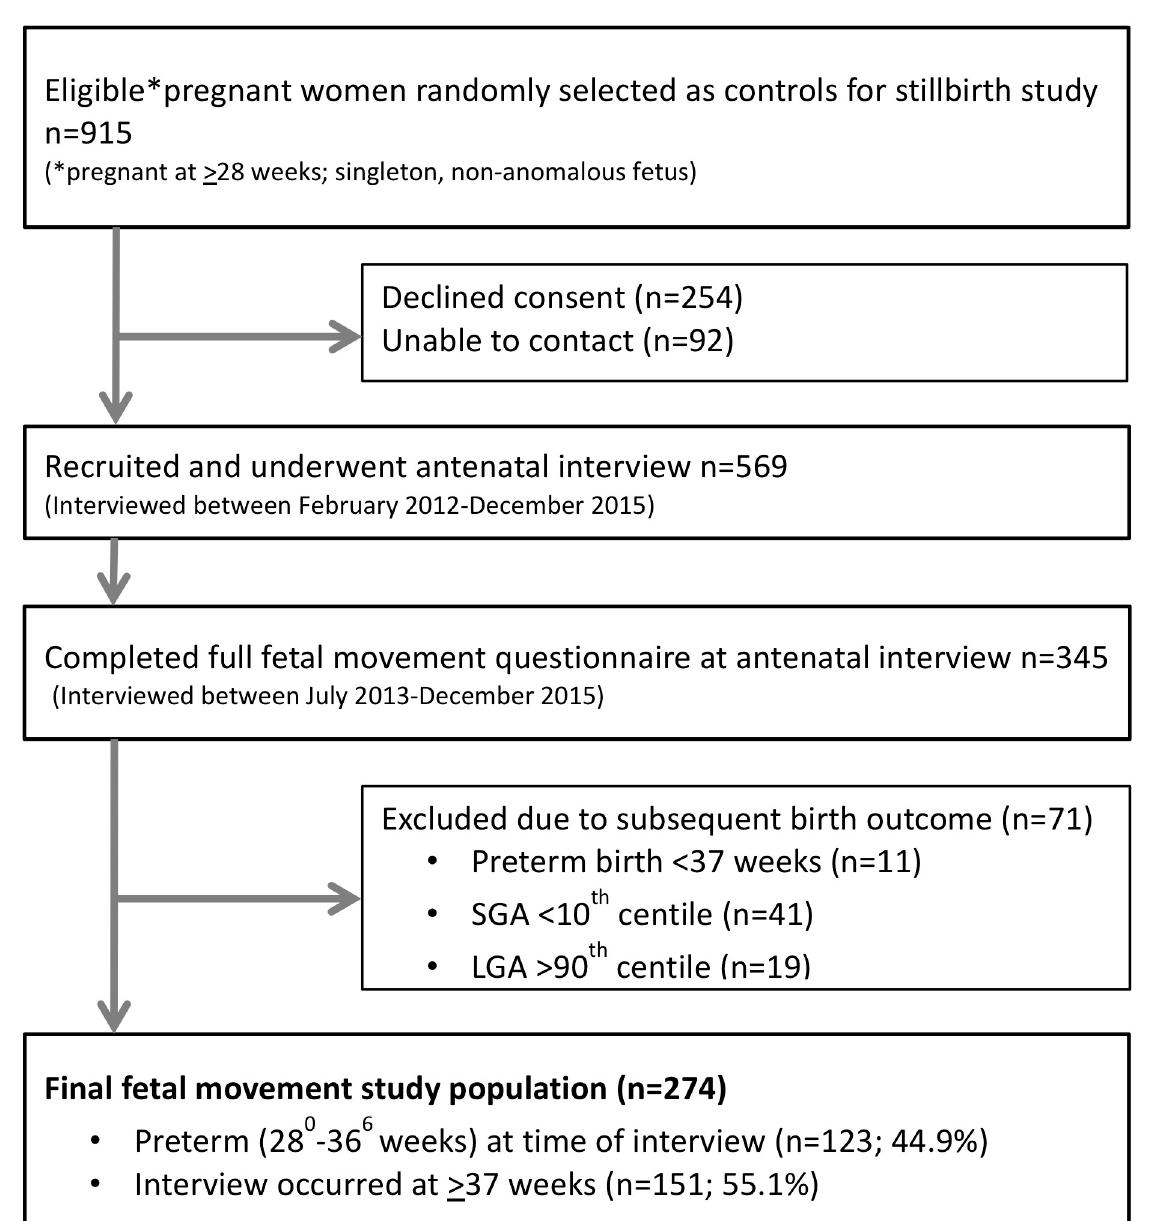
Fig 1. Study population flow